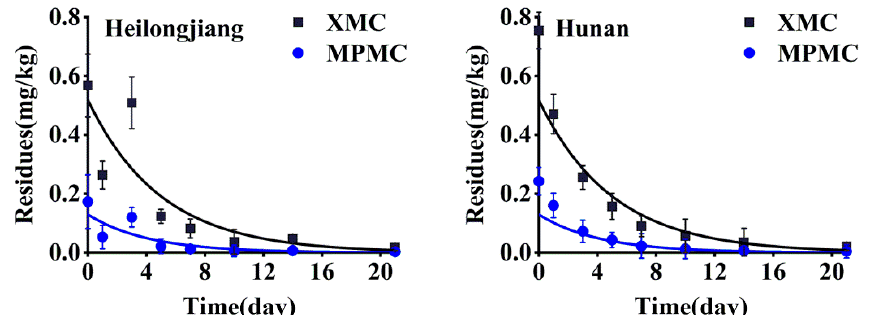
Figure 5. The dissipative curve of dimethacarb in rice straw.